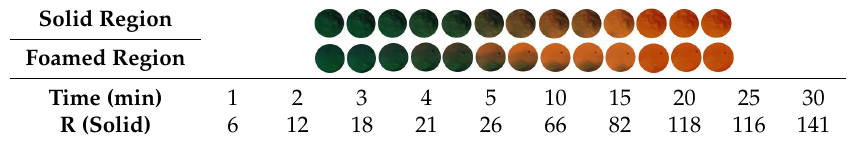
Figure 2. Detection process: Picture of the Hg(II) solution with the immersed films ( left ), and circular section selected from the picture of the film to obtain the RGB parameters ( right ). Table 1. RGB data from photographs taken from the solid and foamed regions of the sensory films after immersion for 60 min at RT in aqueous solutions (pH = 2.2, KCl–HCl) with a fixed concentration (913 ppm) of Hg(II).